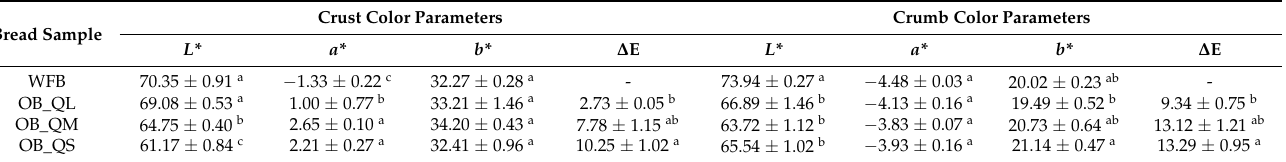
Table 4. Color parameters of breads with the optimal dose corresponding to large, medium and small particle size of quinoa flour vs. wheat flour bread. Crust Color Bread Sample